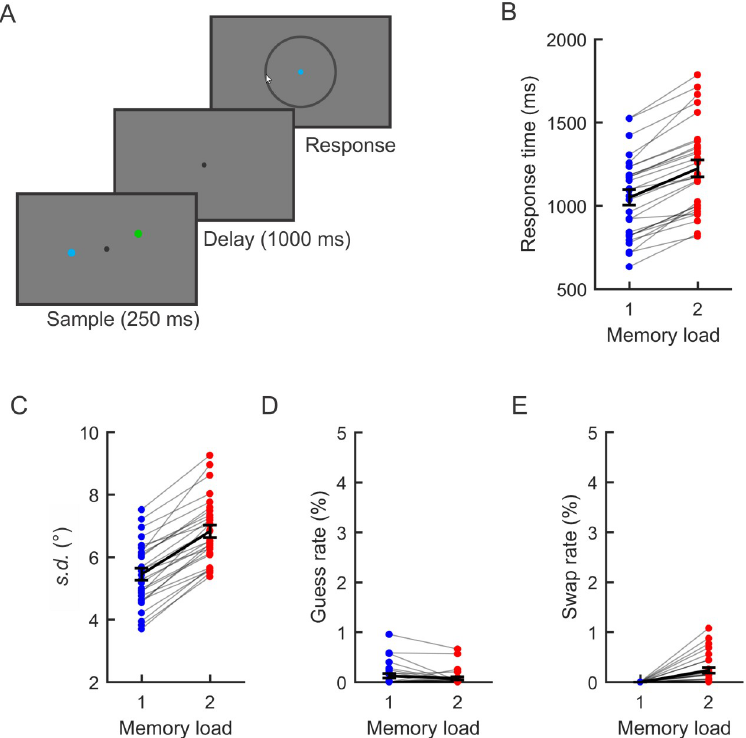
Fig 1. Experimental task and behavior. (A) Observers saw a brief sample display (250 ms) that contained 1 or 2 colored dots. After a delay period (1,000 ms), the fixation point changed color (blue or green) to indicate which item should be reported. Observers reported the angular position of the cued item as precisely as possible by mouse click on the perimeter of a rim. (B) Median response time (ms) as a function of memory set size (1 versus 2 items). Light grey lines represent individual observers. Black lines represent the mean. Error bars represent ± 1 SEM. (C–E) Parameter estimates obtained by fitting a three-component mixture model [50] to response errors as a function of memory set size. s . d . (panel C) reflects precision of responses (with higher values indicating worse precision), pGuess (panel D) estimates the probability that the observer produced a random response (i.e., a guess), and pSwap (panel E)